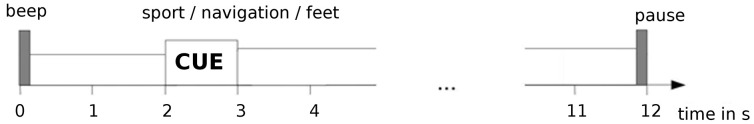
Experimental paradigm for measurements in patients. Timeline of a single trial is shown here.